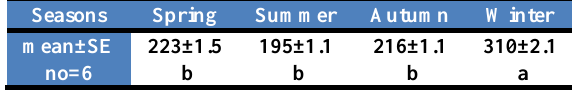
Table, 4: Tubular area (µm) during different seasons in dog.